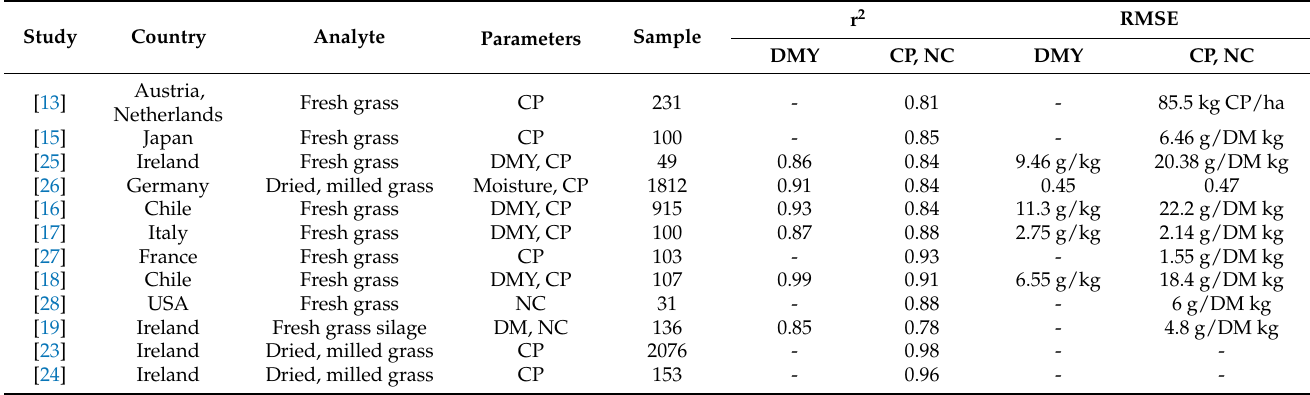
Table 3. Performance of calibrations for DMY, NC or crude protein (CP) in related research.